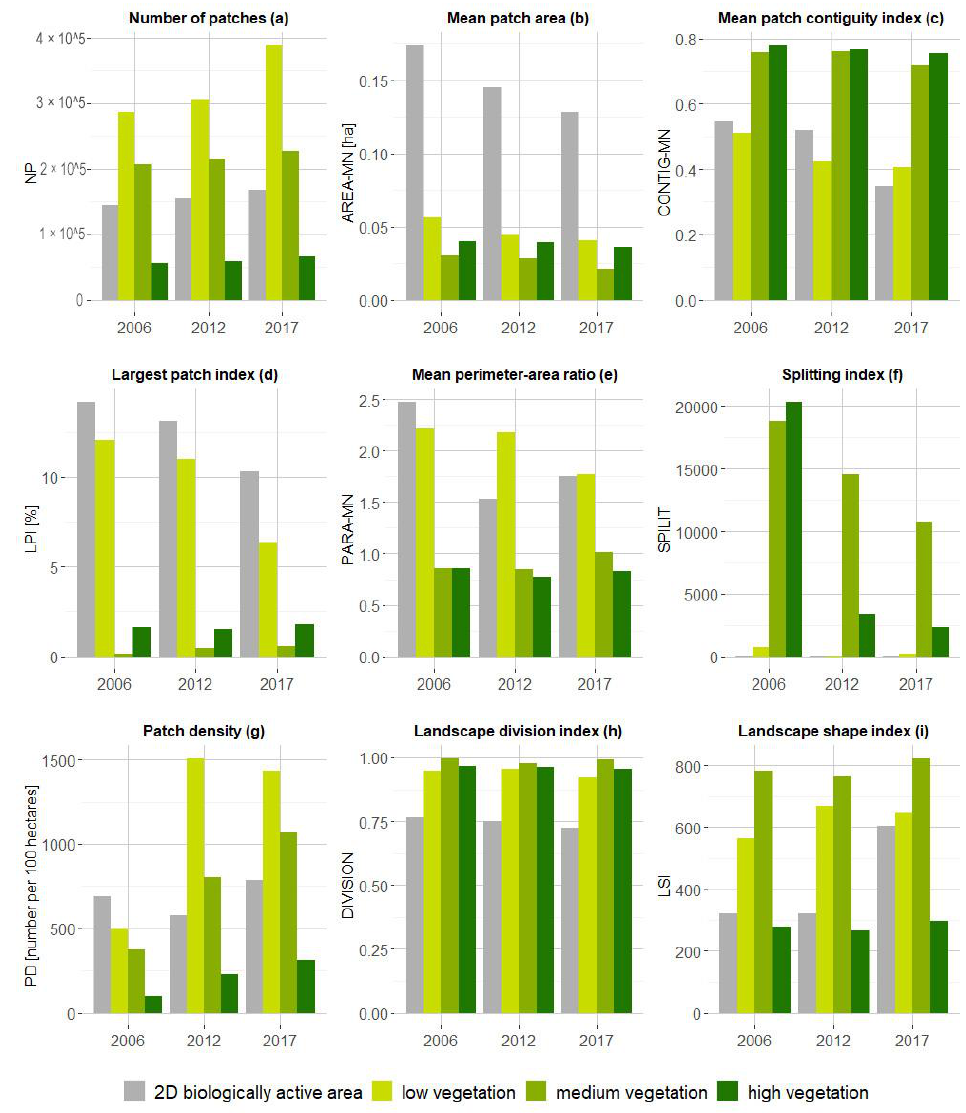
Figure 8. Landscape metrics derived from the analysis of the 2D biologically active area (2D BAA; grey bars) and 3D structural layers—low, medium, and high vegetation (LV, MV, and HV; greenish bars) in 2006, 2012, and 2017.